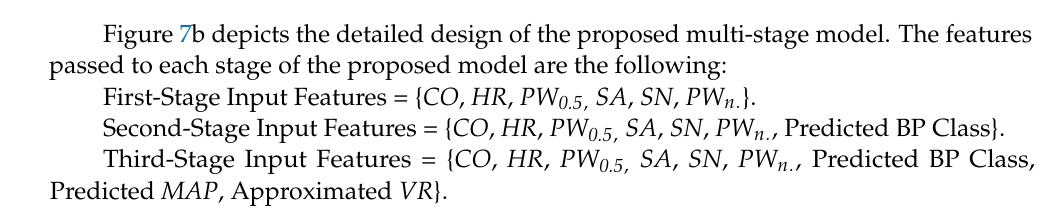
Figure 7. The proposed LSTM Multi-Stage Model. ( a ) General Architecture of the Proposed Multi- Stage Model. ( b ) The Proposed LSTM Multi-Stage Model Design.